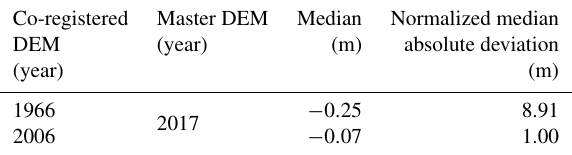
Table 9. Stable terrain statistics after